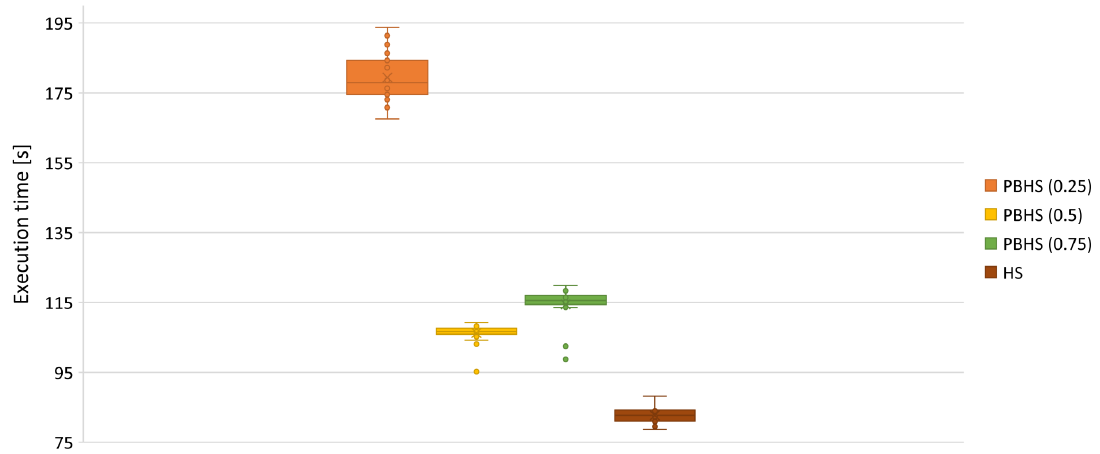
Figure 5. Comparison of results for case study (execution